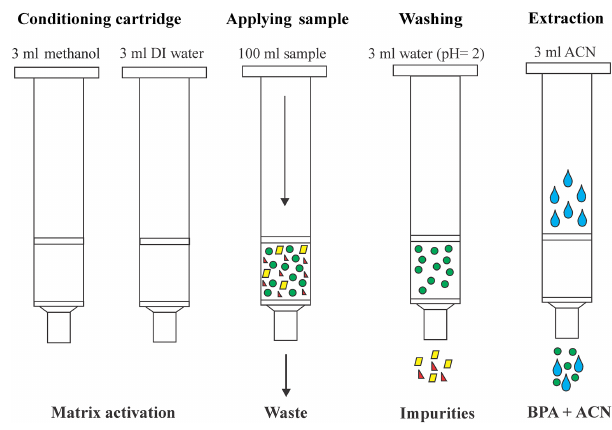
Figure 3. The steps of solid-phase extraction.